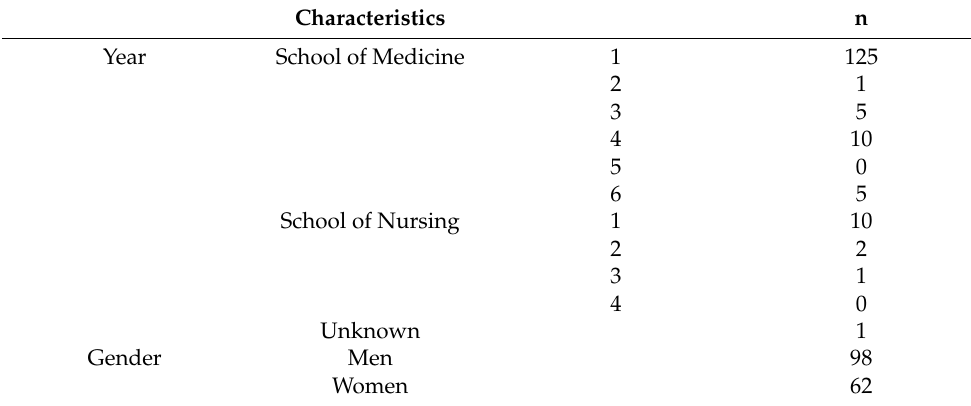
Table 1. Characteristics of